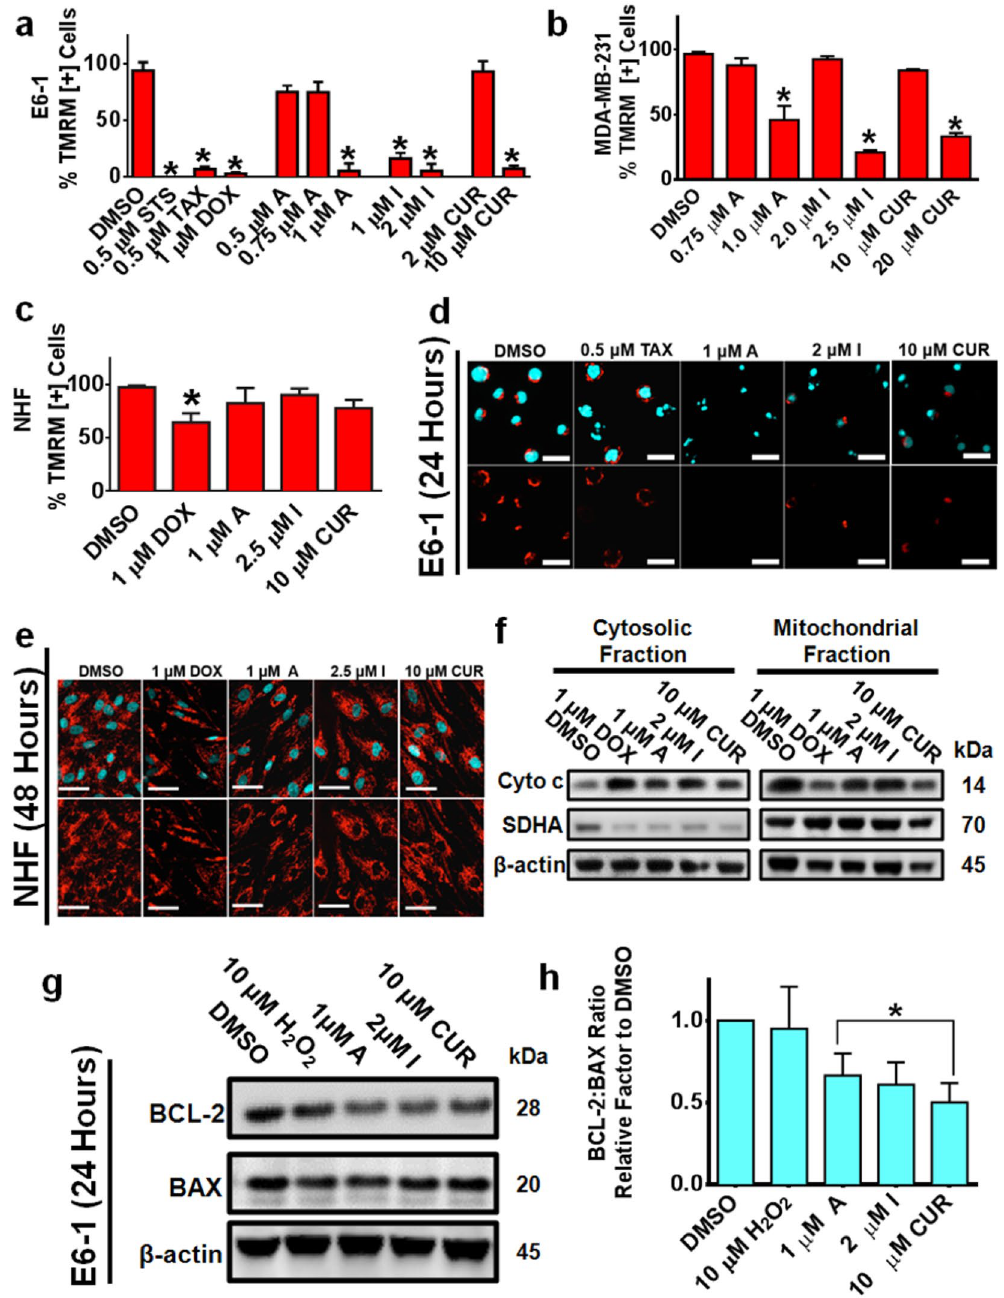
Figure 4. Selective Mitochondria Destabilization Following Treatment with Curcumin Analogs. ( a–c ) The cancerous cell lines E6-1 and MBA-MD-231 and normal cell line NHF were treated for 48 hours. To monitor mitochondria potential cells were incubated with TMRM for 45 minutes before analysis. Results were obtained using image-based cytometry with the Y-axis representative of percent of cells positive for TMRM expressed as a mean ± SD from three independent experiments. ( d ) Fluorescent microscopy images of acute T-cell leukemia (E6-1) cells stained with TMRM (red) and Hoechst (cyan) at 24 hours. Scale bar 25 microns. ( e ) Fluorescent microscopy images of NHF stained with TMRM (red) and Hoechst (cyan) at 48 hours. Scale bar 50 microns. Images are representative of three independent trials. ( f ) E6-1 cells were treated for 24 hours, following which the cytoplasmic and mitochondria fractions were separated and subjected to Western blot analysis. ( g ) E6-1 cells were treated for 24 hours, following which cells were lysed and subjected to Western blot analysis. Bands were visualized using a chemiluminescent reagent. ( h ) Densitometry results were obtained using Image J and are shown as a ratio of BCL-2 to BAX following normalization to β –actin. Results are representative of three independent trials. Statistical calculations were performed using One-Way ANOVA multiple comparison. * p < 0.05 vs Control